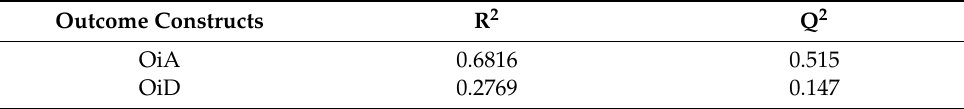
Table 7. The quality of the structural model. Outcome